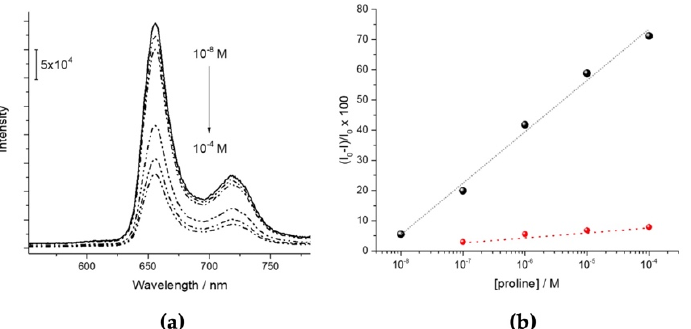
Figure 9. ( a ) Fluorescence quenching of H 2 P(L)Pro( − ) LS film in the presence upon exposure to aqueous solutions of (L)-proline at increasing concentrations. ( b ) Quenching of fluorescence of H 2 P(L)Pro( − ) LS film in the presence of (L)-proline (black dots) and (D)-proline (red dots). Adapted from OPEN ACCESS [40].